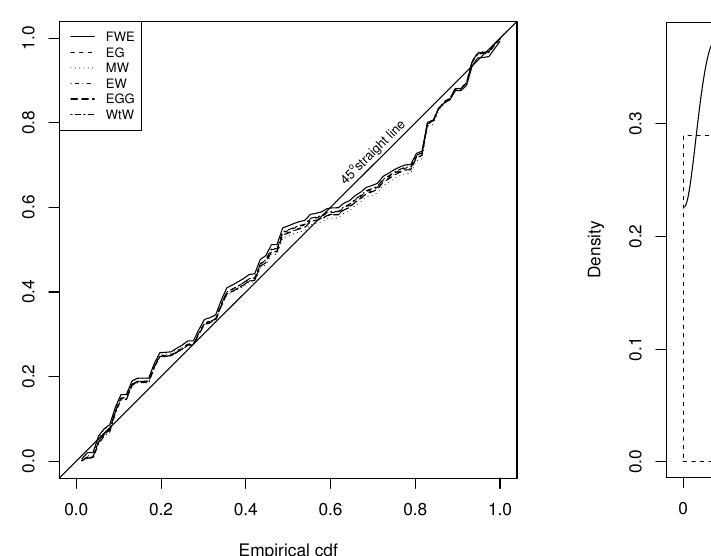
Figure 3. Probability-Probability (PP) plots of the distributions for failure times data.